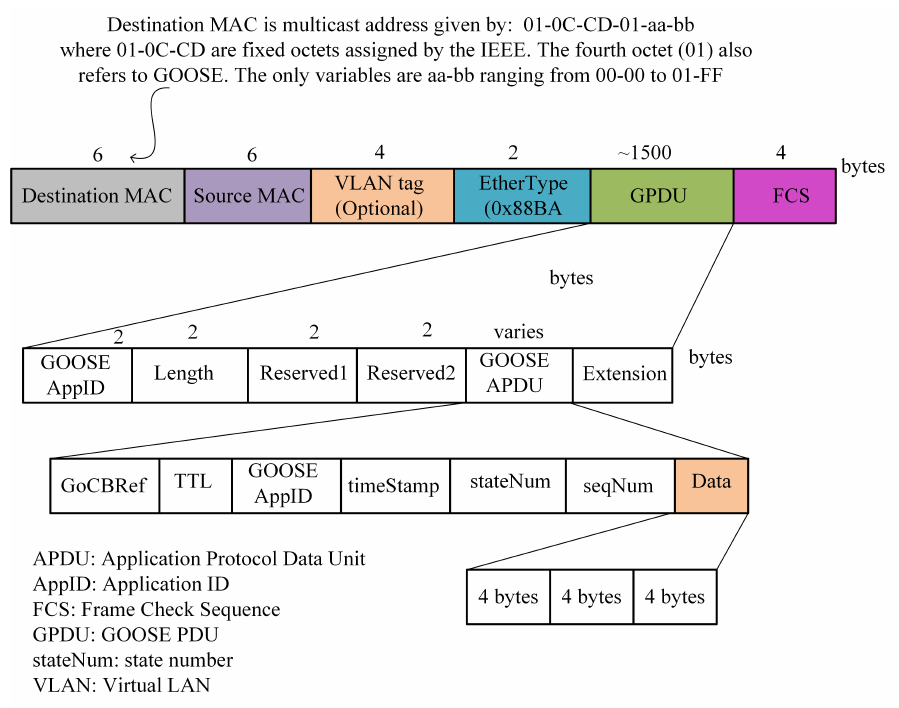
Figure 4. GOOSE frame